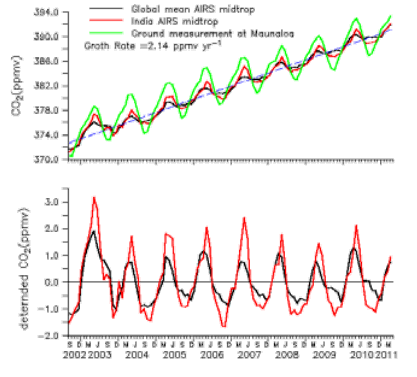
Figure 2 Monthly maps of mid-tropopsheric CO 2 over the India and surrounding oceans based on AIRS observation during a climatological year